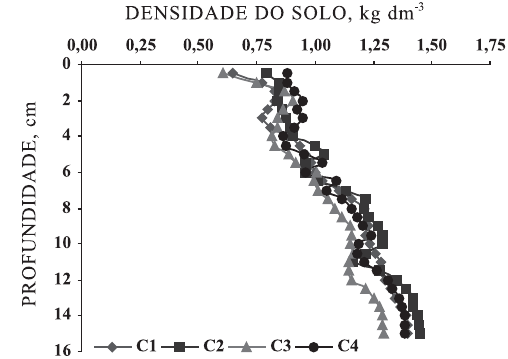
N).Figura 4. Perfil da densidade média do solo obtida por tomografia computadorizada para o teor de água do solo U = 0,27 kg kg -1 , em razão das cargas aplicadas (C1 = 0 N, C2 = 50 N, C3 = 90 N e C4 = 140 N).